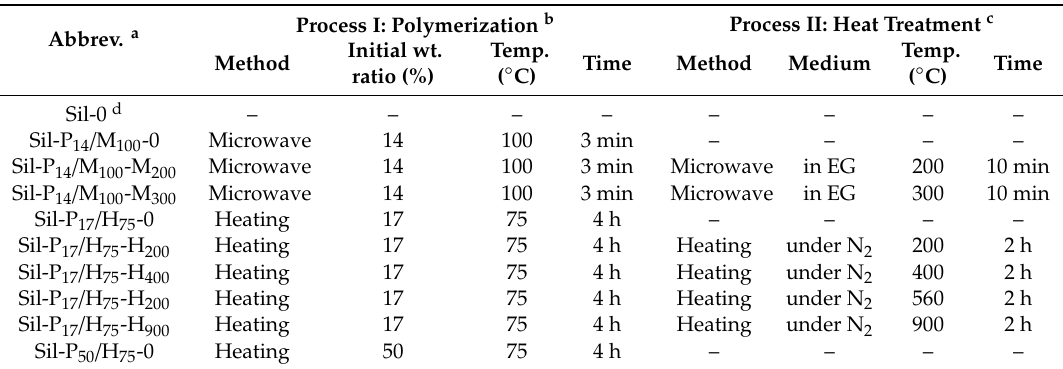
Table 2. The reaction conditions for the polymer lamination and heat treatment for blackening. Abbrev.